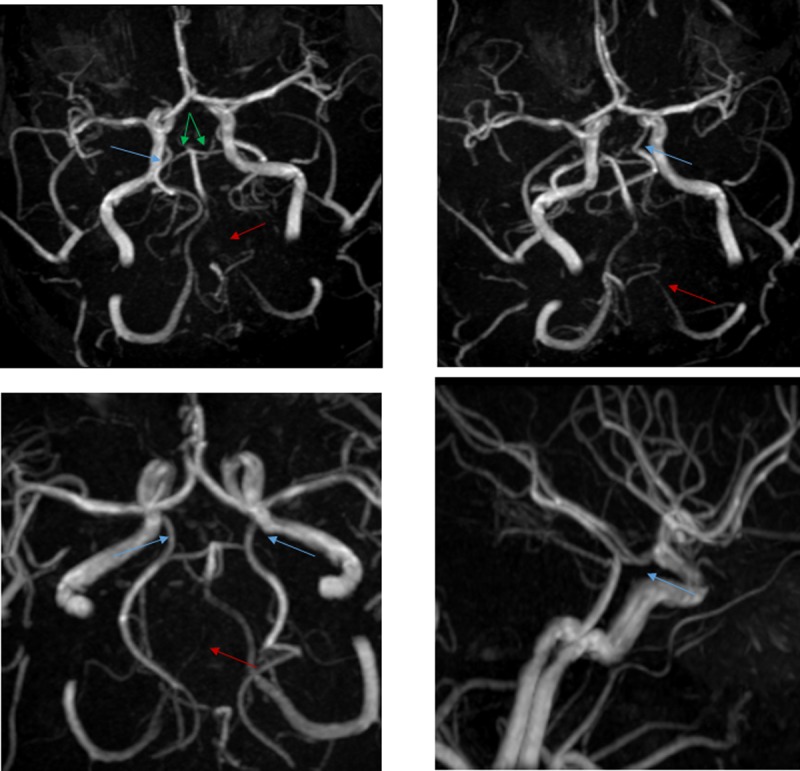
Fetal circle Willis.Blue arrow points to fetal posterior cerebral artery, green arrow points to absence of P1 segment, red arrow points to hypoplastic vertebral artery.